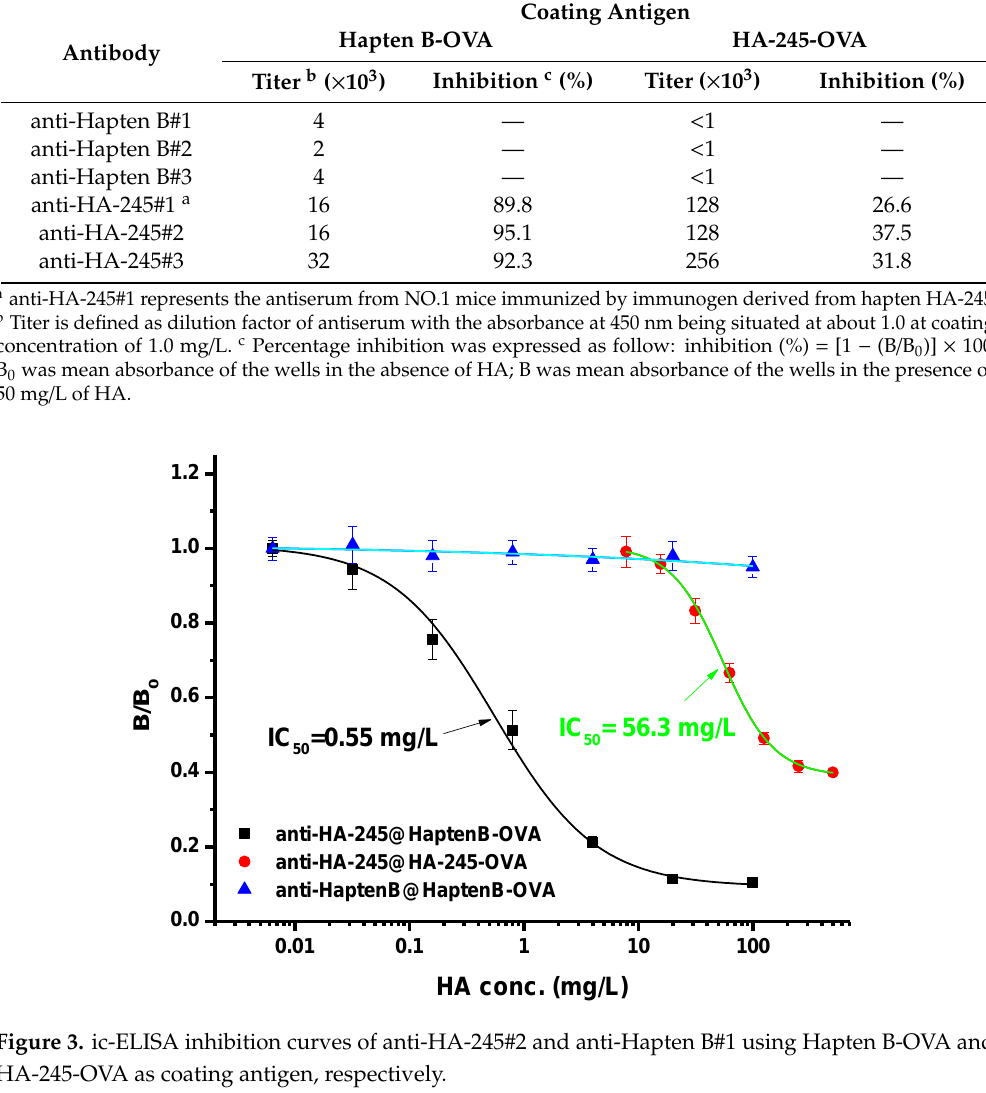
Table 1. Characterization of anti-HA serum obtained after the fourth immunization by competitive and non-competitive ELISA.